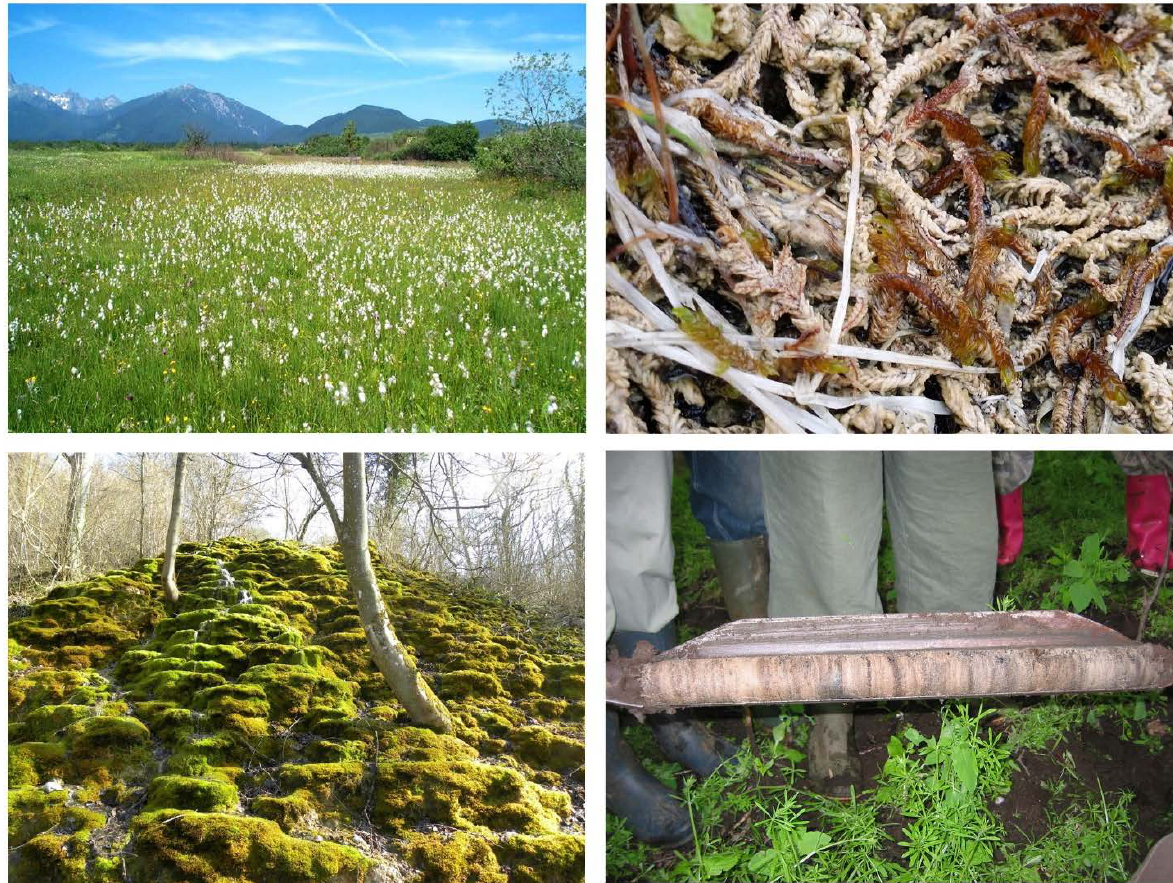
Figure 3. Top left: a calcareous mire (Belianske Lúky) at the foot of the Tatra Mountains in Slovakia (photo A.P. Grootjans). Top right: tufa deposition can be observed on the branches of a moss (photo: L. Wołejko ). Bottom left: a hill with tufa deposition dominated by spring mosses (Cascade de Bonne Fontaine) Vodeleé, Belgium, photo: H. de Mars). Bottom right: alternating layers of tufa and peat in a in a core from a Calcareous-spring-mire in East Poland, photo: A.P.